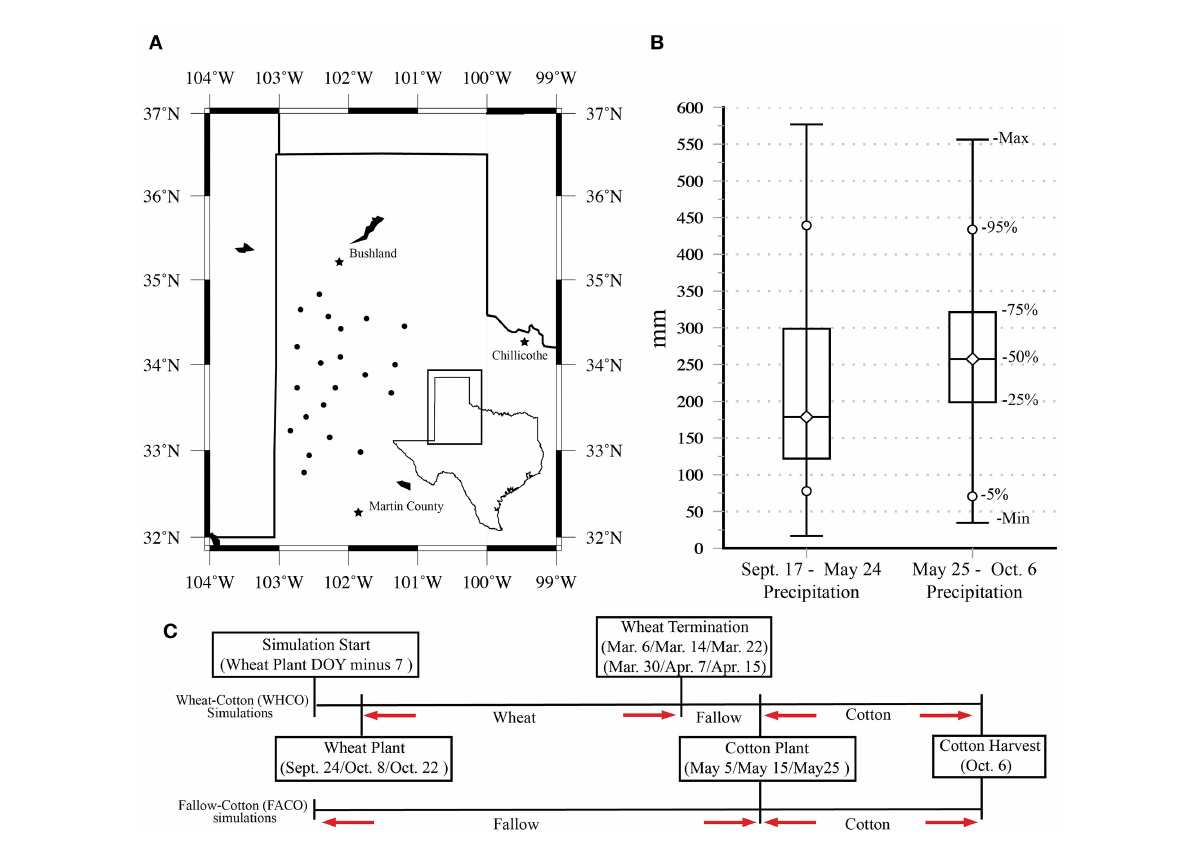
FIGURE1 (A) Locations of 21 west Texas Mesonet weather stations. Starred locations mark the locations of the Texas A&M AgriLife Research Station at Chillicothe TX, the USDA-ARS research station at Bushland, TX, and the Martin County, TX, field research site. (B) Distributions of cumulative Sept.17–May 25 and May 25–0ct. 6 rainfall aggregated from the 21 mesonet stations during 2005–2006 to 2018–2019. (C) Schematic time lines of the terminated wheat-cotton (WHCO) and fallow-cotton (FACO) control